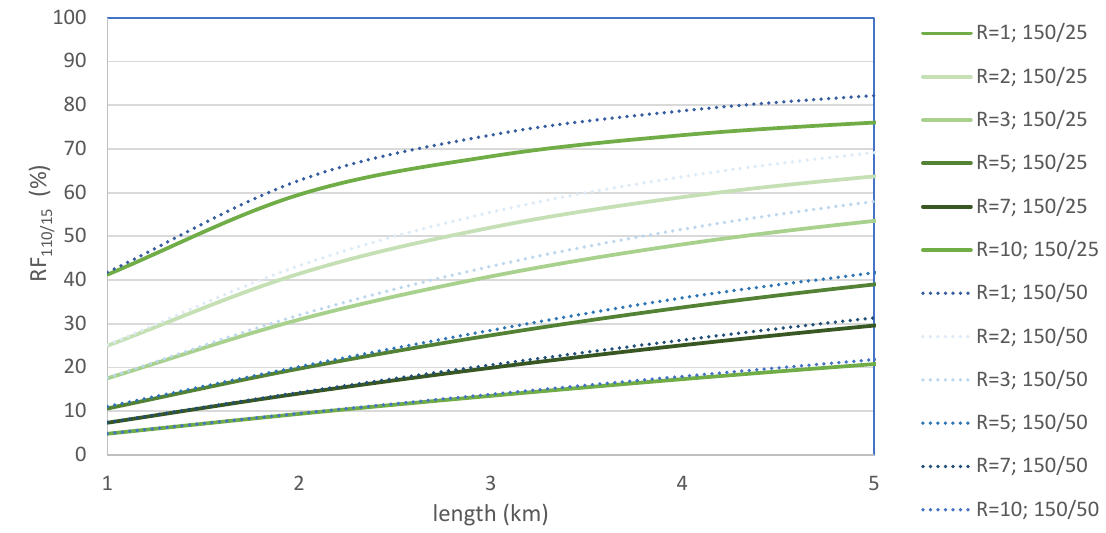
Figure 13. RF 110/15 for faults in overhead section of mixed feeder (cable in a trefoil configuration).